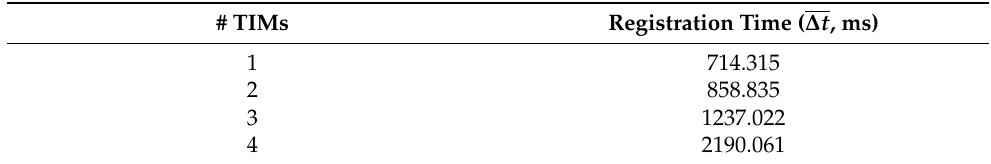
Table 1. Registration Test—Total Times, n